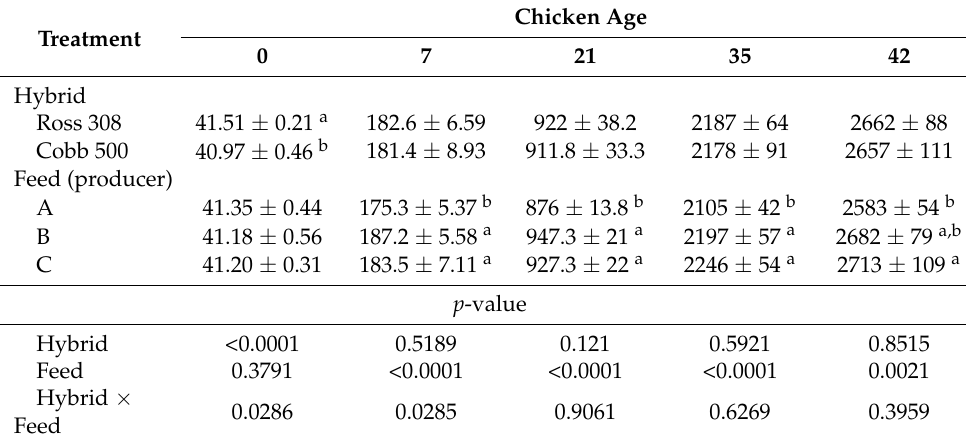
Table 3. Broiler body weight in rearing two different hybrids with different market feeds (mean ± standard deviation),